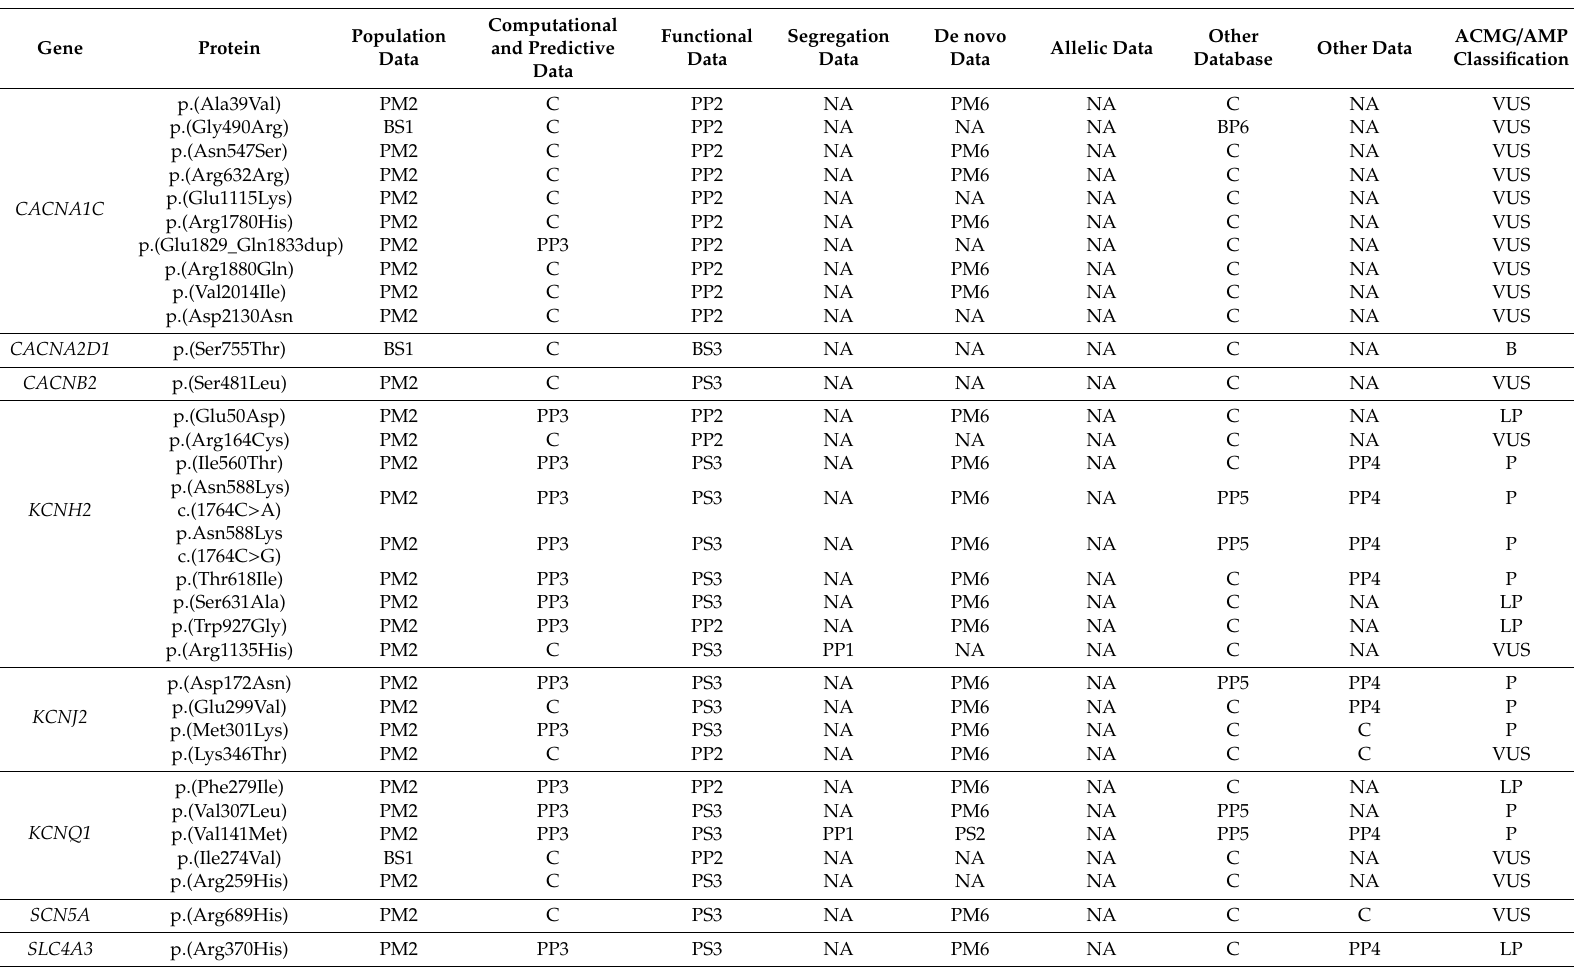
Table 3. Classification of variants following American College of Medical Genetics and Genomics / Association for Molecular Pathology (ACMG / AMP) criteria.